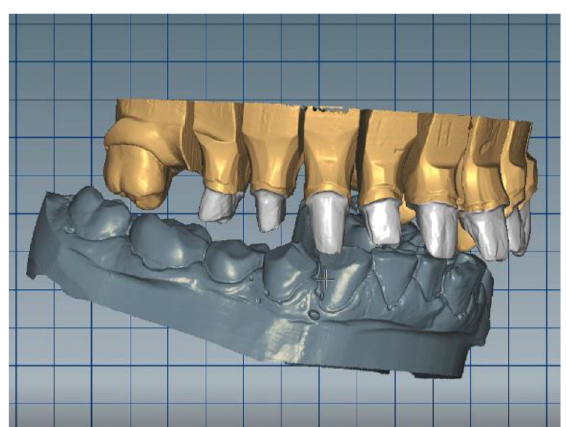
Figure 8. Clinical situation after upper preparation with increased VDO.